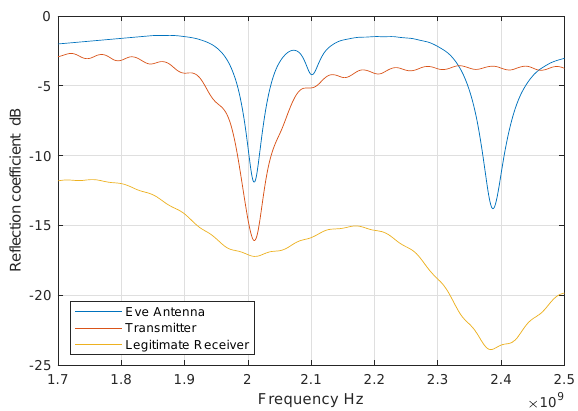
Figure 4. Reflection coefficients for Legitimate and Eavesdropper antennas